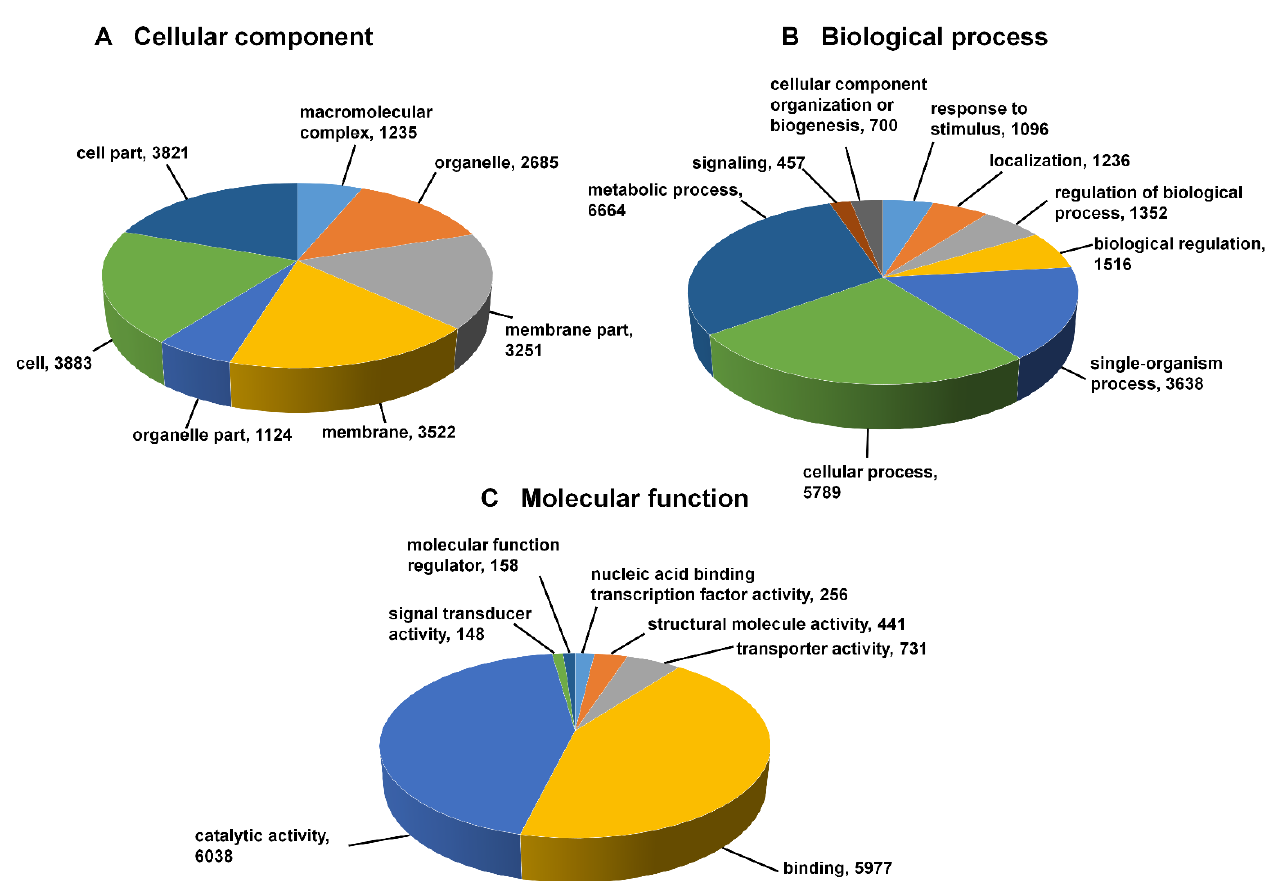
Figure 5. Distribution of gene ontology annotation assigned by Blast2 GO. This figure describes the three GO categories: cellular component ( A ), biological processes ( B ), and molecular functions ( C ).